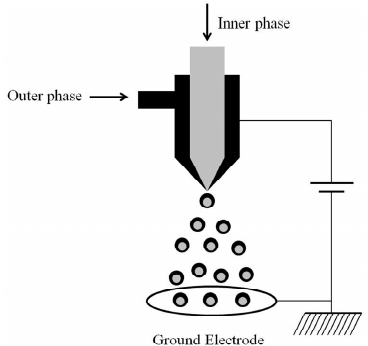
Figure 1. Typical experimental